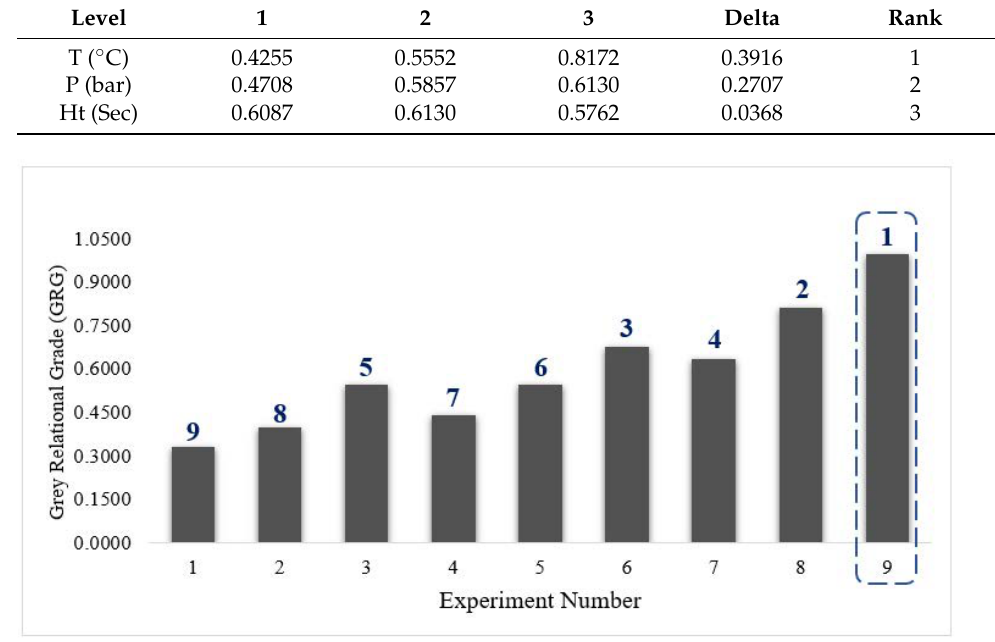
Figure 15. Grey relational grade for all experiments.